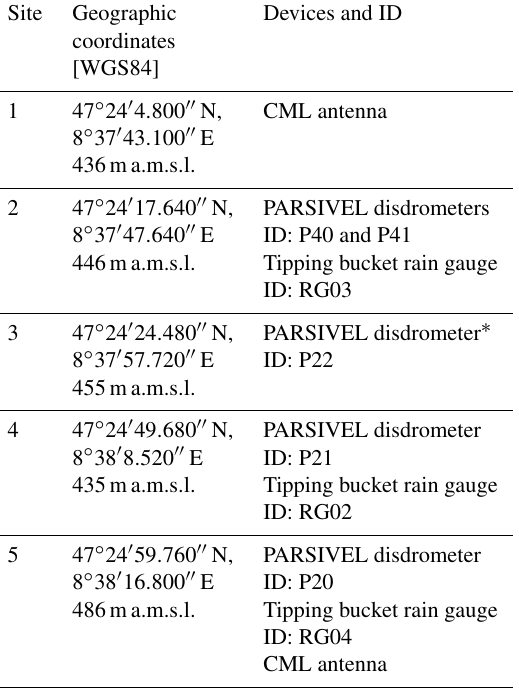
Table 1. Locations of the sites and deployed